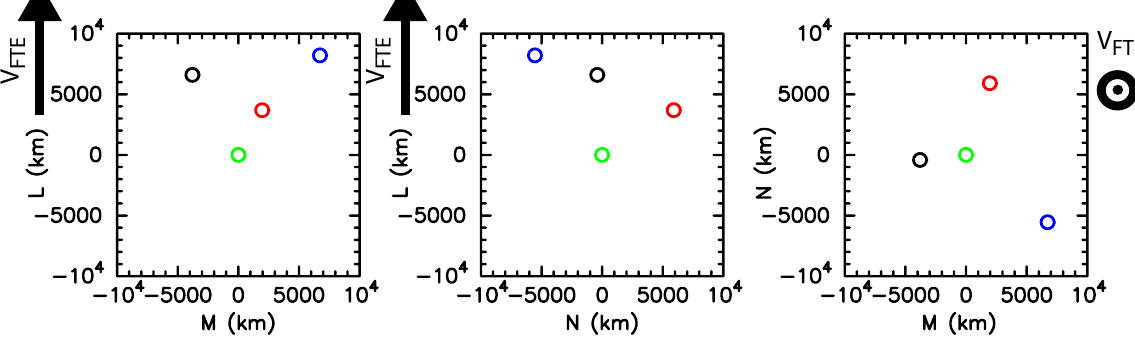
Fig. 4. The orientation of the Cluster spacecraft at 19:30UT in boundary normal coordinates. The panels indicate, from left, the LM, LN and MN planes. Each spacecraft is represented by a circle, using the same colour code as used in Fig. 2. The velocity of the FTE discussed in Sect. 4.4 is indicated beside each